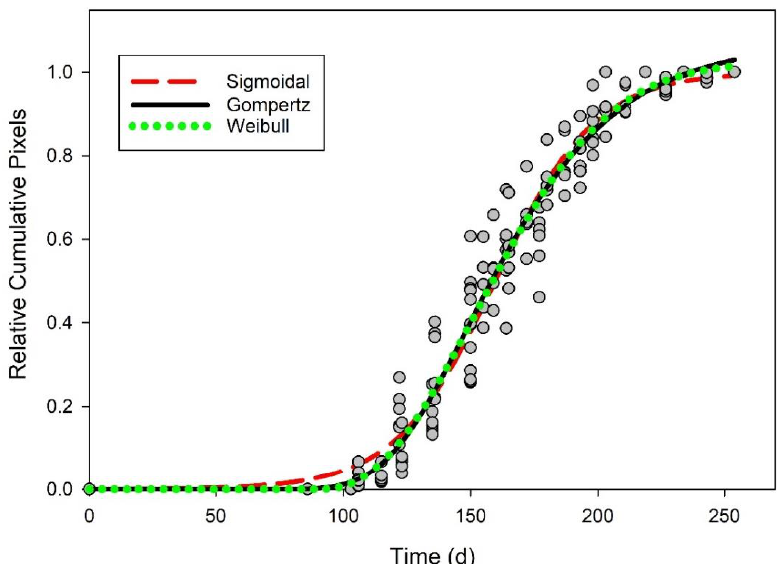
Figure 2. Relative cumulative pixels over time in days (gray circles). Three different equations were fit to the data as a predictive model for emergence of Senna obtusifolia : Sigmoidal (red dashed line), Gompertz (solid line), and Weibull (green dotted line).